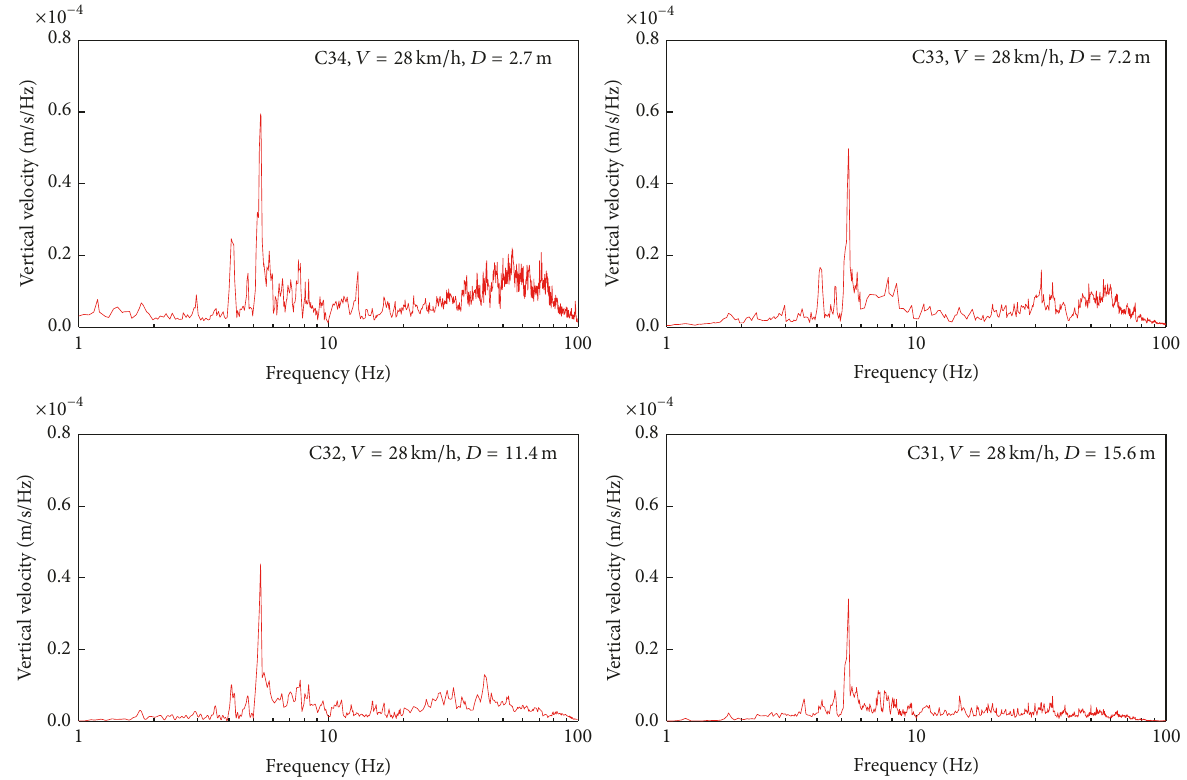
Figure 9: Frequency spectrum of the vertical embankment surface velocity at train speed of 28